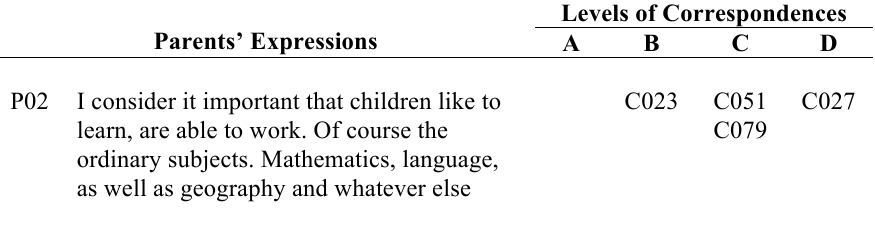
Table 3 Interpretations of Correspondences Between Children’s and Parents’ Expressions